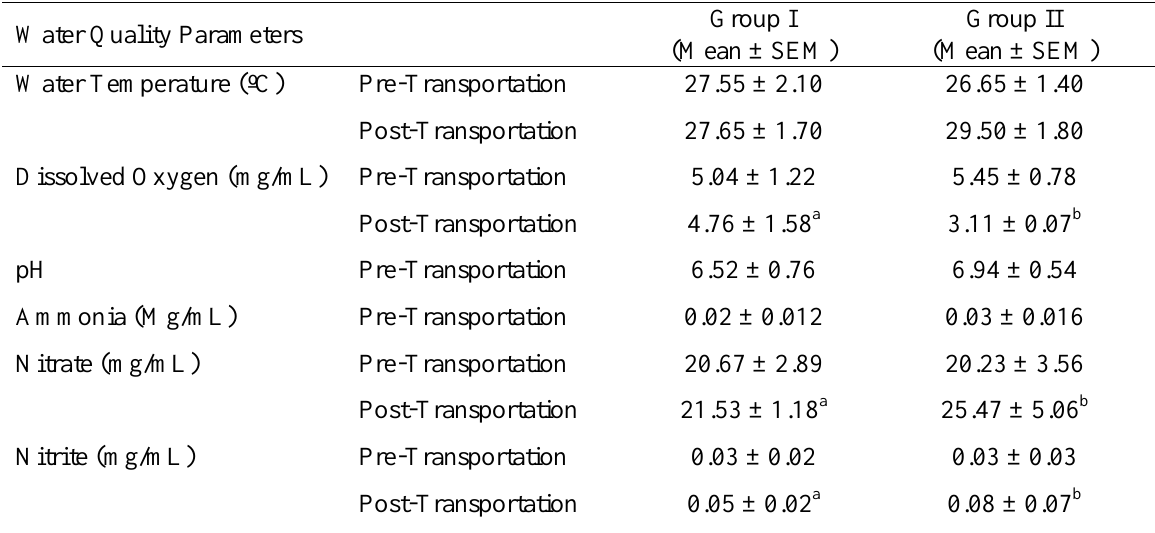
Table 1: Water Quality Parameters of Clarias gariepinus subjected to Road Transportation Water Quality Parameters